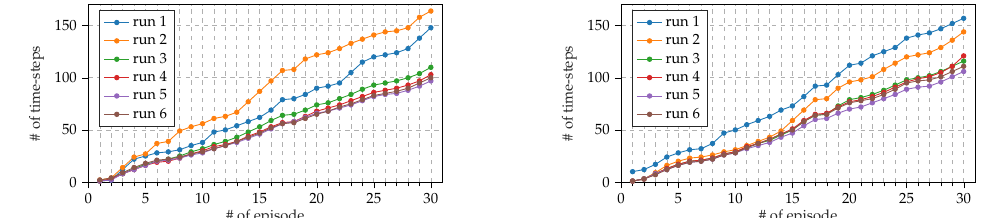
Figure 4. Cumulated time-steps during all the episodes for each run of the online iLQR (Section 3.2) and of GA (Section 3.2). Better performance is achieved by the online iLQR that requires a samller total number of time-steps starting from the third test phase, the first completely successful one for both